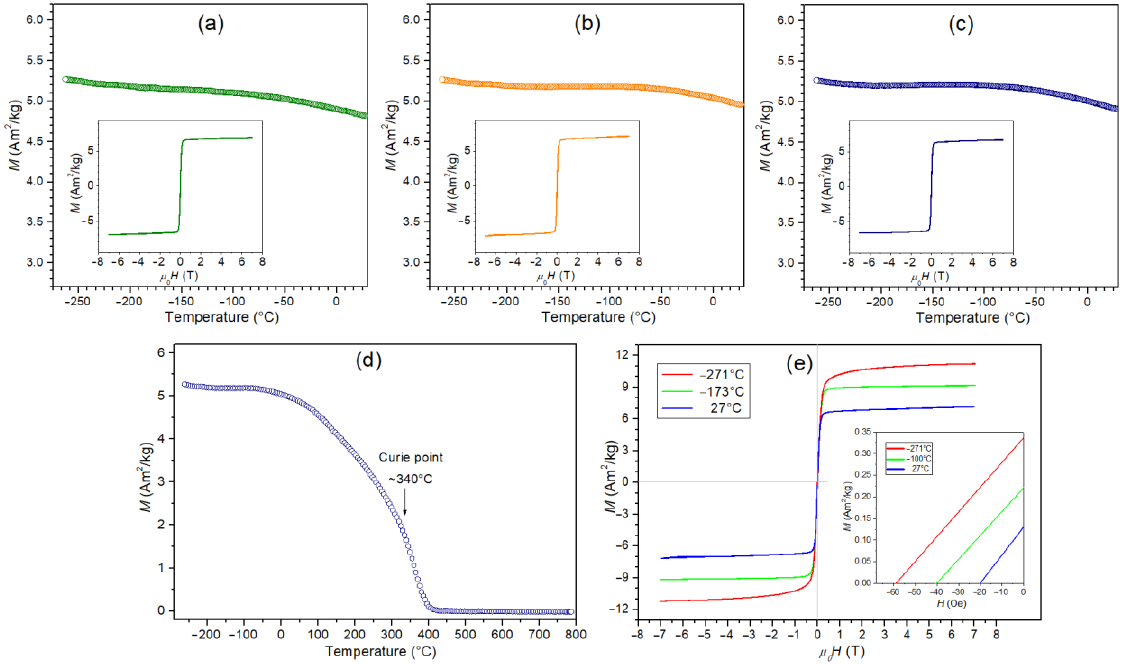
Figure 11. Temperature dependencies of M magnetization for PF composite samples: PF-SPS ( a ), PF-HP ( b ), and PF-FS ( c ), inset — magnetic hysteresis loops tested at RT ; temperature dependencies of M magnetization ( d ) and magnetic hysteresis loops for the PF-FS composite sample ( e ), inset — coercivity in a narrower temperature range.